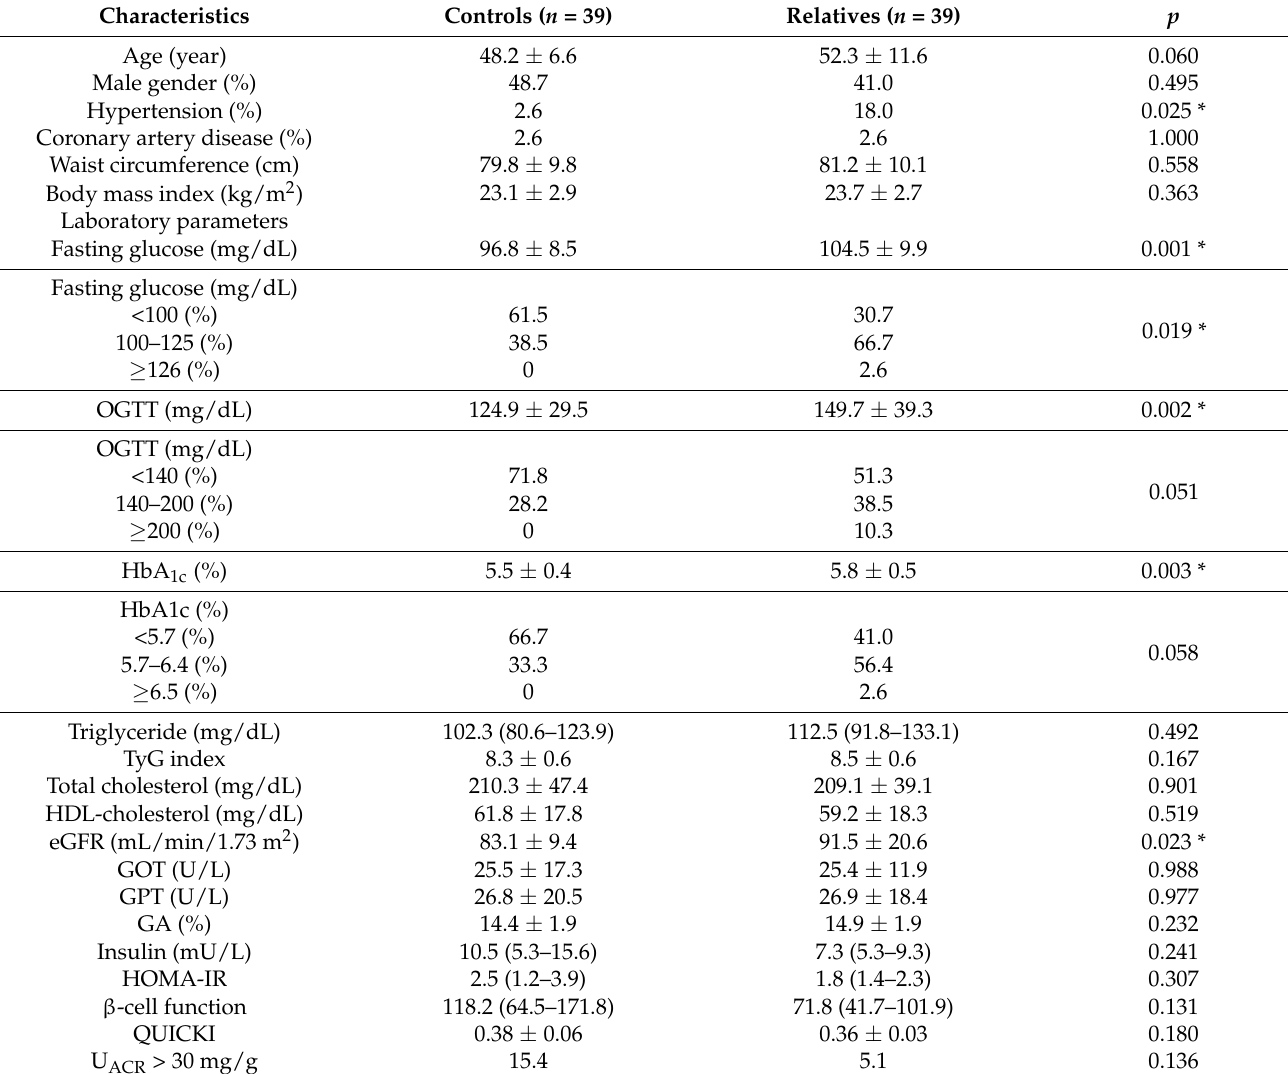
Table 6. Comparison of clinical characteristics between controls and relatives of DM patients by age, sex and BMI match.